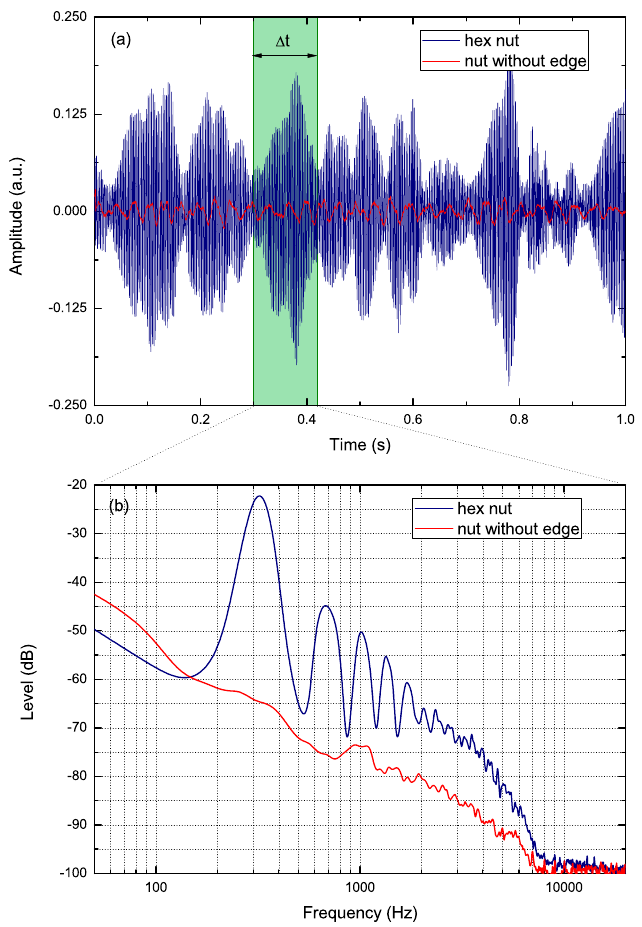
Fig. 4. (a) Signal in time domain of two audios. (b) Spectrum of a segment of these two audio of the same duration ( ∆ t ). The blue line is for the nut A and a balloon of mean radius ( 9 . 7 ± 0 . 2 )cm, with peak intensity of (345 ± 11) Hz, and red line is for the nut S and a balloon of mean radius ( 9 . 1 ± 0 . 2